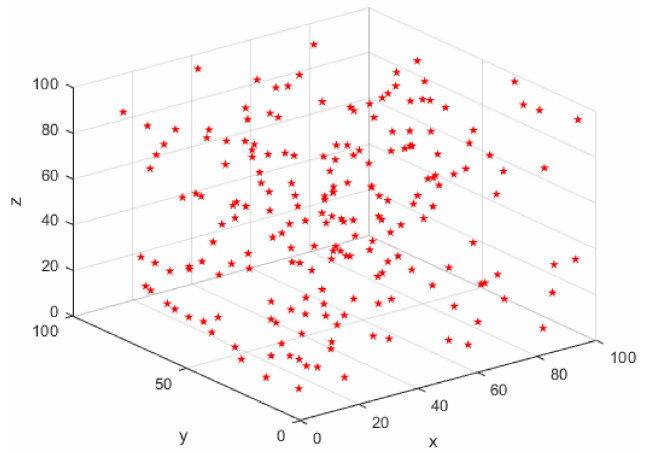
Figure 1. Three-dimensional coordinates of fibers randomly distributed in space.